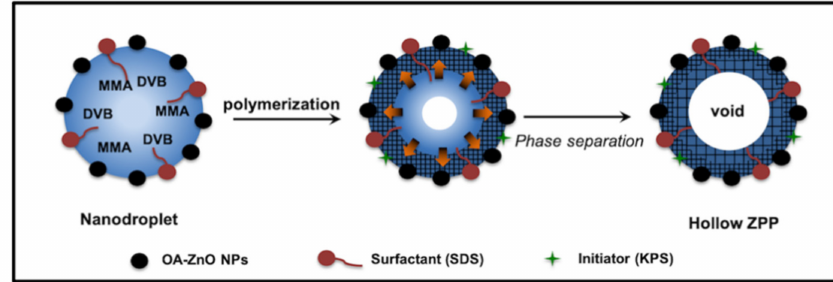
Figure 7. Scheme of hollow structure